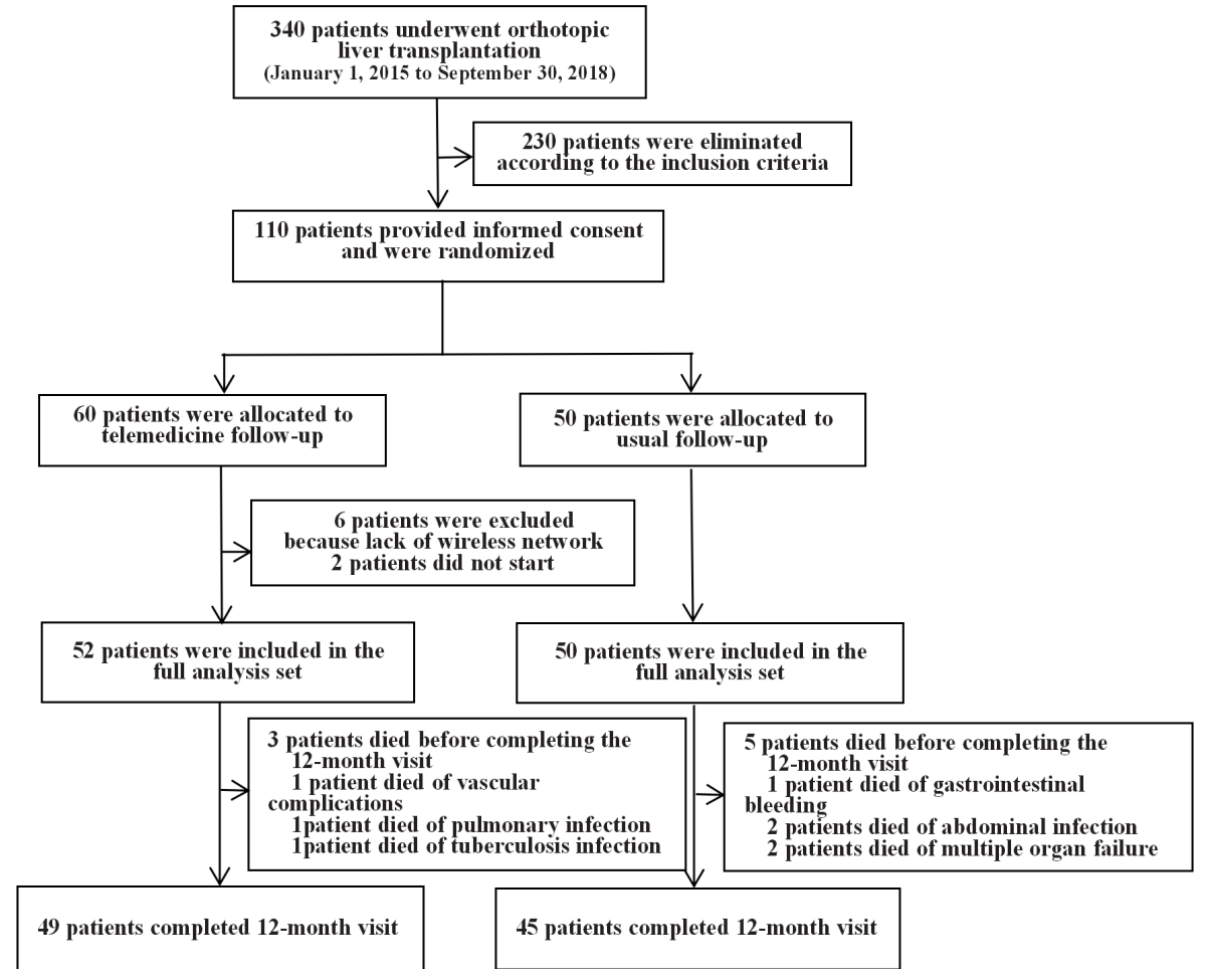
Figure 2. Procedures and participants in the telemedicine follow-up management clinical observation